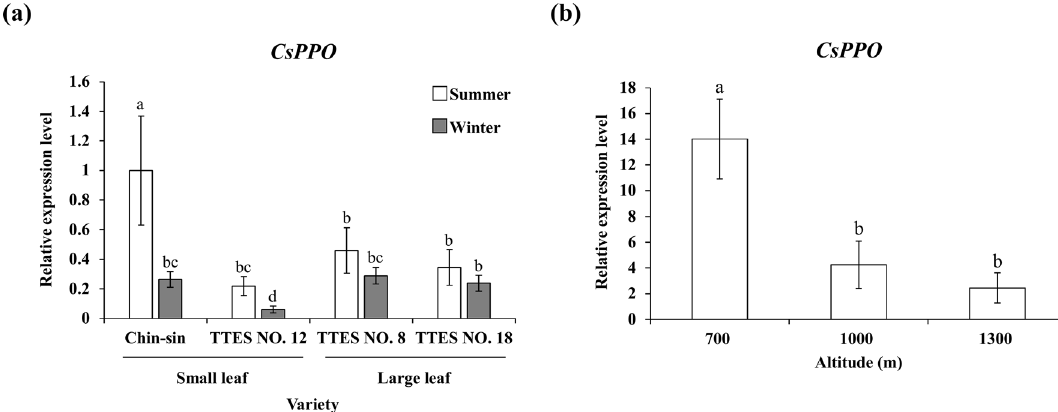
Figure 3. CsPPO transcript level in different harvesting seasons and plantation altitudes. Samples of each variety were collected in the summer and winter of 2018. The Chin-shin samples from different plantation altitudes were collected from tea gardens in Alishan, Chiayi. Total RNA was extracted from the young leaves of each sample. CsPPO transcript levels were measured using qRT-PCR and normalized to that of 18S rRNA. Values are presented as the mean ± SD of three biologically independent experiments. Different letters indicate significant difference between samples assessed using the LSD post hoc test ( p < cultivated at different altitudes. The CsPPO transcript level in the young leaves of Chin-shin and TTES No. 12 were significantly higher in summer than in winter (Fig. 3a). However, the same expression pattern was not observed in TTES No. 8 and TTES No. 18. This result indicates that the CsPPO transcript level in the small-leaf variety was more sensitive to seasonal changes than that in the large-leaf variety.